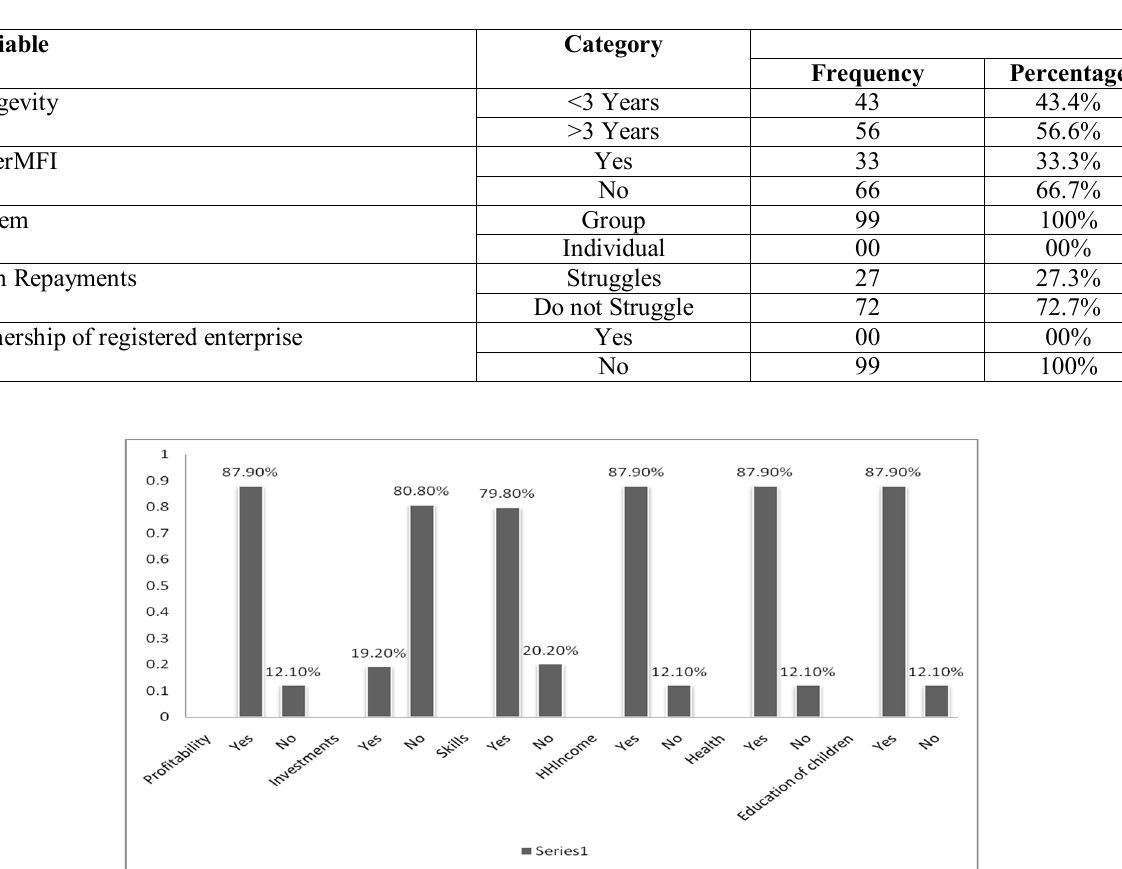
Table 2: Institutional information